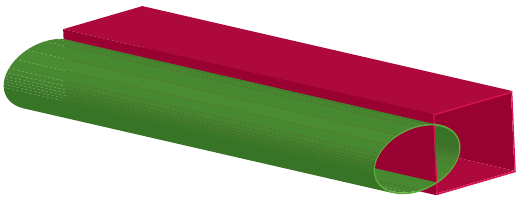
FIG. 2. The vacuum chamber is the union of a number of subchambers. This figure illustrates this showing two subchambers — one colored green and the other colored red.